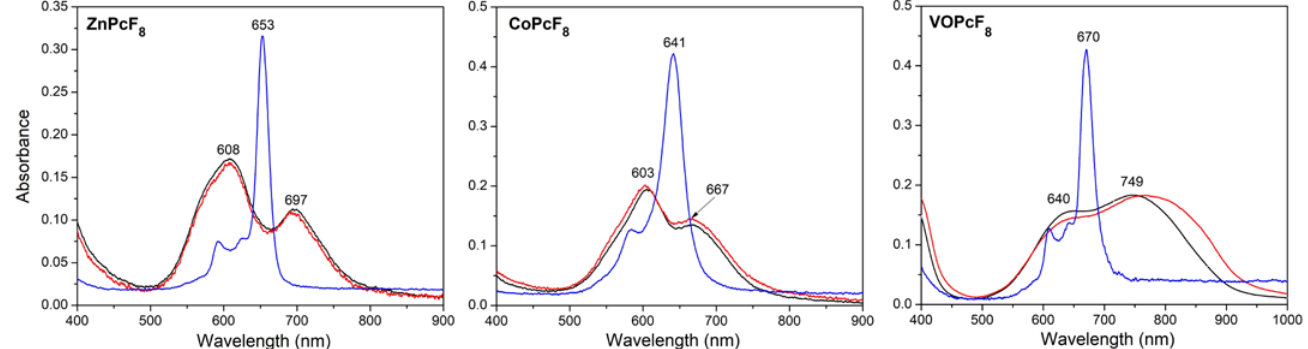
Figure 9. Optical absorption spectra of MPcF 8 (M=Zn, Co, VO) solutions in THF (blue lines) and films deposited on glass slides before (black lines) and after heating at 200 °C for 3 h (red lines).